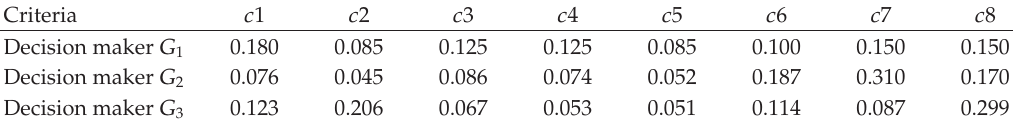
Table 13: Computed global weights for criteria through AHP.